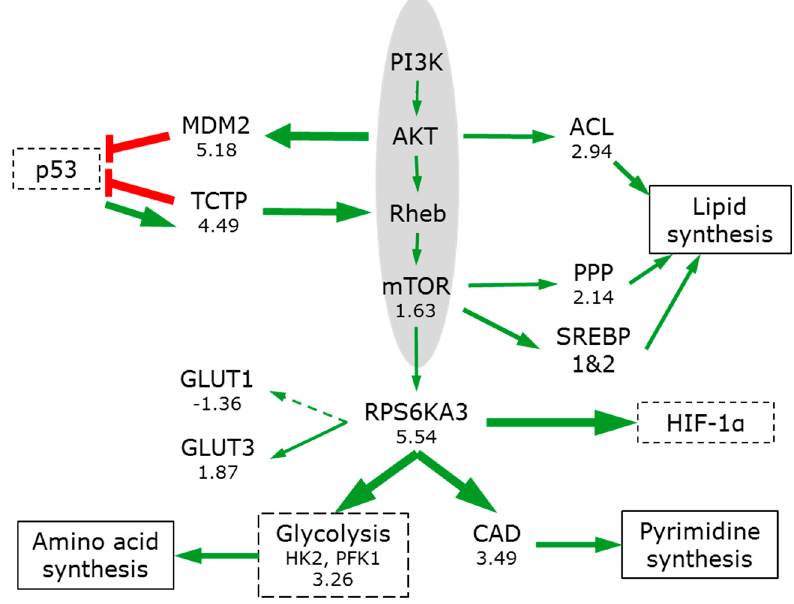
Figure 6. mTOR signalling in 3D spheroids. See legend to Figure 4 for nomenclature.